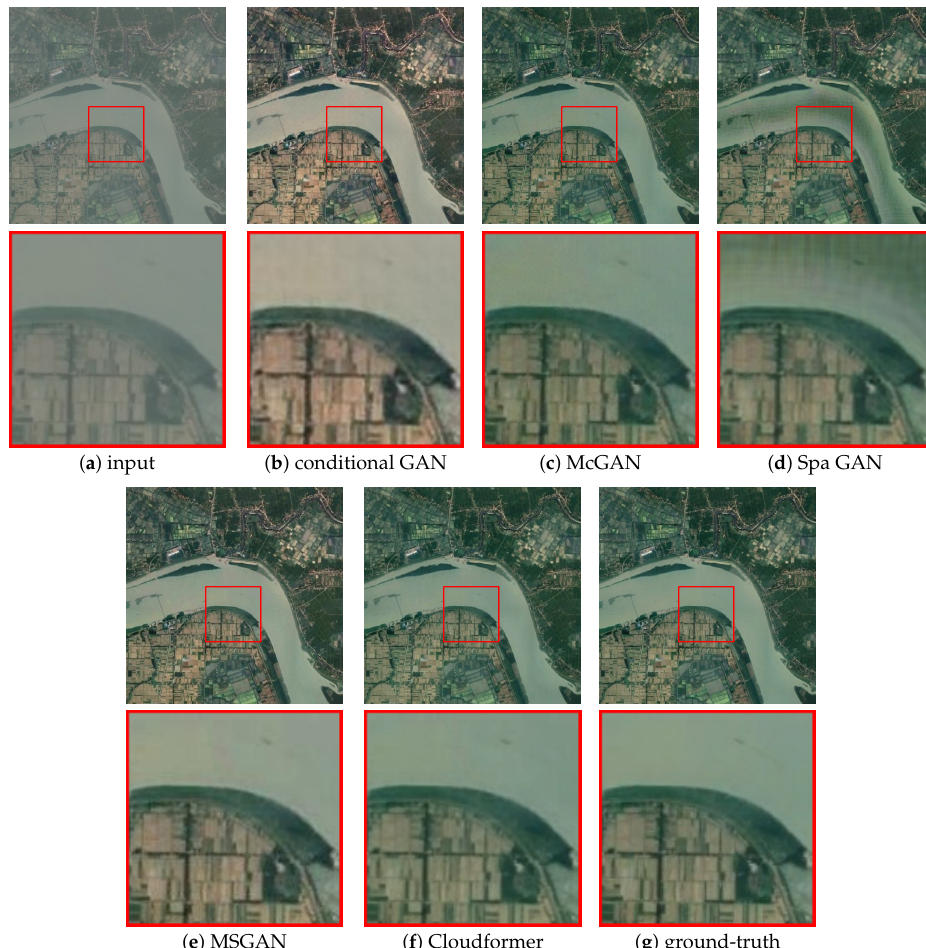
Figure 9. Comparative experimental results on the first sample of RICE1. The results of both conditional GAN and MSGAN show obvious color deviation. The results of Spa GAN show uneven brightness in river regions and wrong textures. In contrast, the color Cloudformer’s result is closer to the ground-truth, there are no obvious wrong textures, and good smoothness is